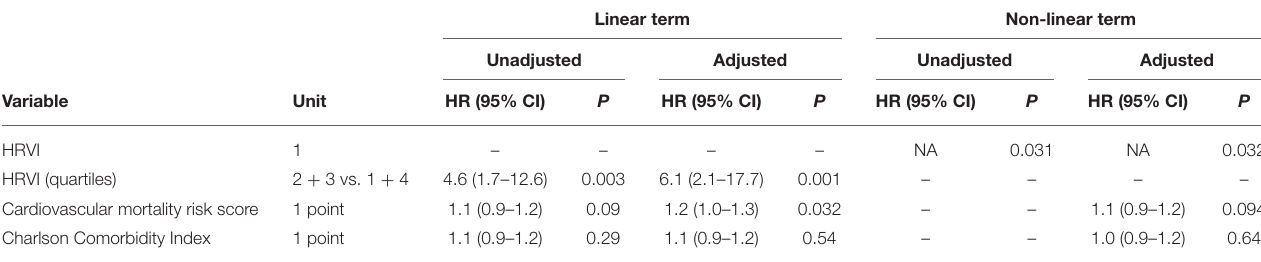
TABLE 3 | Linear and non-linear associations of risk variables with cardiovascular mortality in unadjusted and adjusted Cox regression analysis.